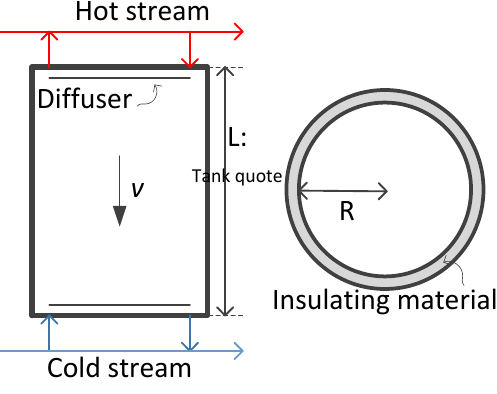
Figure 4. Schematic of the storage